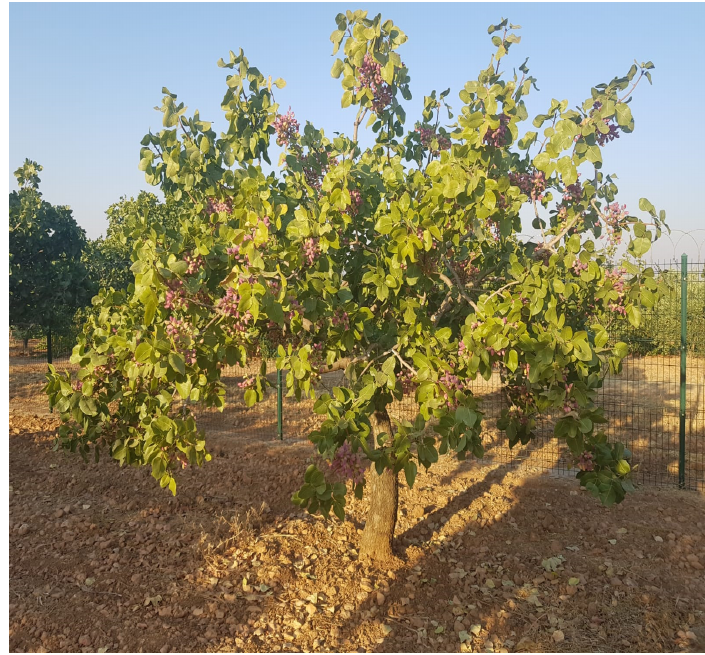
Figure 2. P. vera L.cv. Kirimizi. (Own photography).